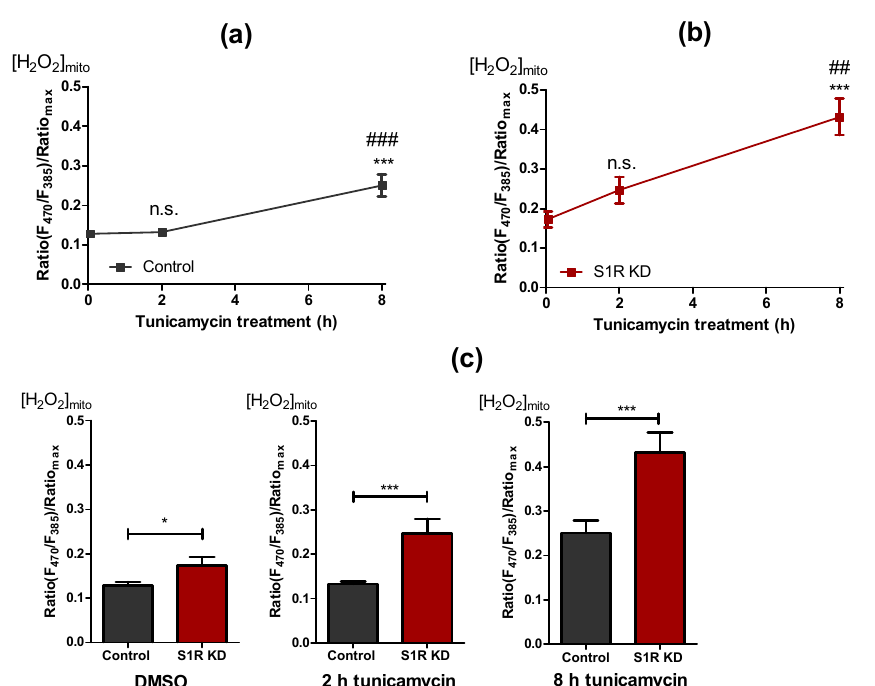
Figure 5. S1R KD is accompanied by increased ROS levels. Time course of mitochondrial H 2 O 2 levels after tunicamycin treatment, presented as mean ± SEM and assessed by the mitoHyPer7 in control SH-SY5Y cells ( a ) and in cells with S1R KD ( b ). Bar graphs represent mean ± SEM of mitochondrial H 2 O 2 levels in control (black) and S1R KD (red) cells before tunicamycin treatment (left), after 2 h (middle), or 8 h (right) tunicamycin treatment ( c ). Comparison of the mitochondrial ROS level in control and S1R KD cells at corresponding treatment durations (error bars are SEM); One-way ANOVA with Tukey’s multiple comparison test ( a , b ), *** p < 0.001, ## p < 0.01 (for b, S1R KD 8 h against S1R KD 2 h), ### p < 0.001 (for a, control 8 h against control 2 h), n.s.—not significant; unpaired t-test ( c ), * p < 0.05, *** p < 0.001 ; Control DMSO (22 cells/7 experiments), Control 2 h tunicamycin (32 cell/10 experiments), Control 8 h tunicamycin (22 cells/6 experiments), S1R KD DMSO (19 cells/9 experiments), S1R KD 2 h tunicamycin (27 cells/10 experiments), S1R KD 8 h tunicamycin (19 cells/6 experiments).